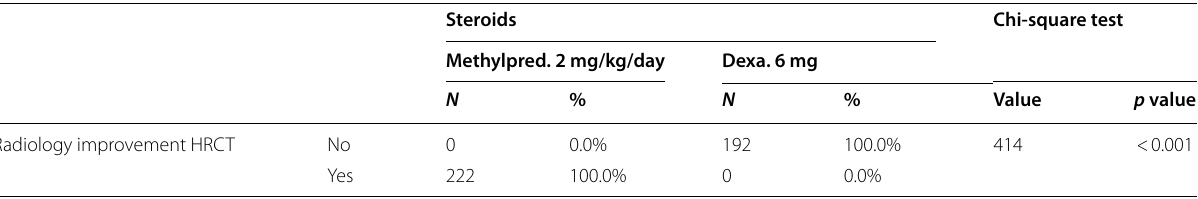
Table 4 Radiological comparison between methylprednisolone group and dexamethasone group